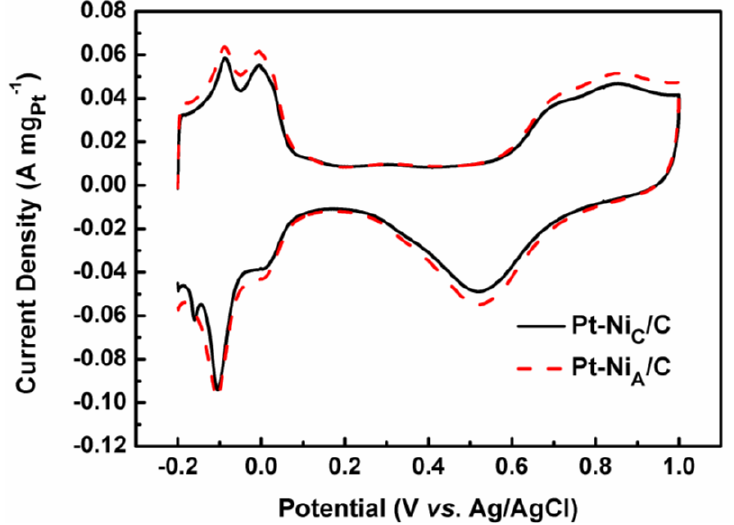
atmosphere at room temperature; Scan rate: 50 mV s −1 . 2